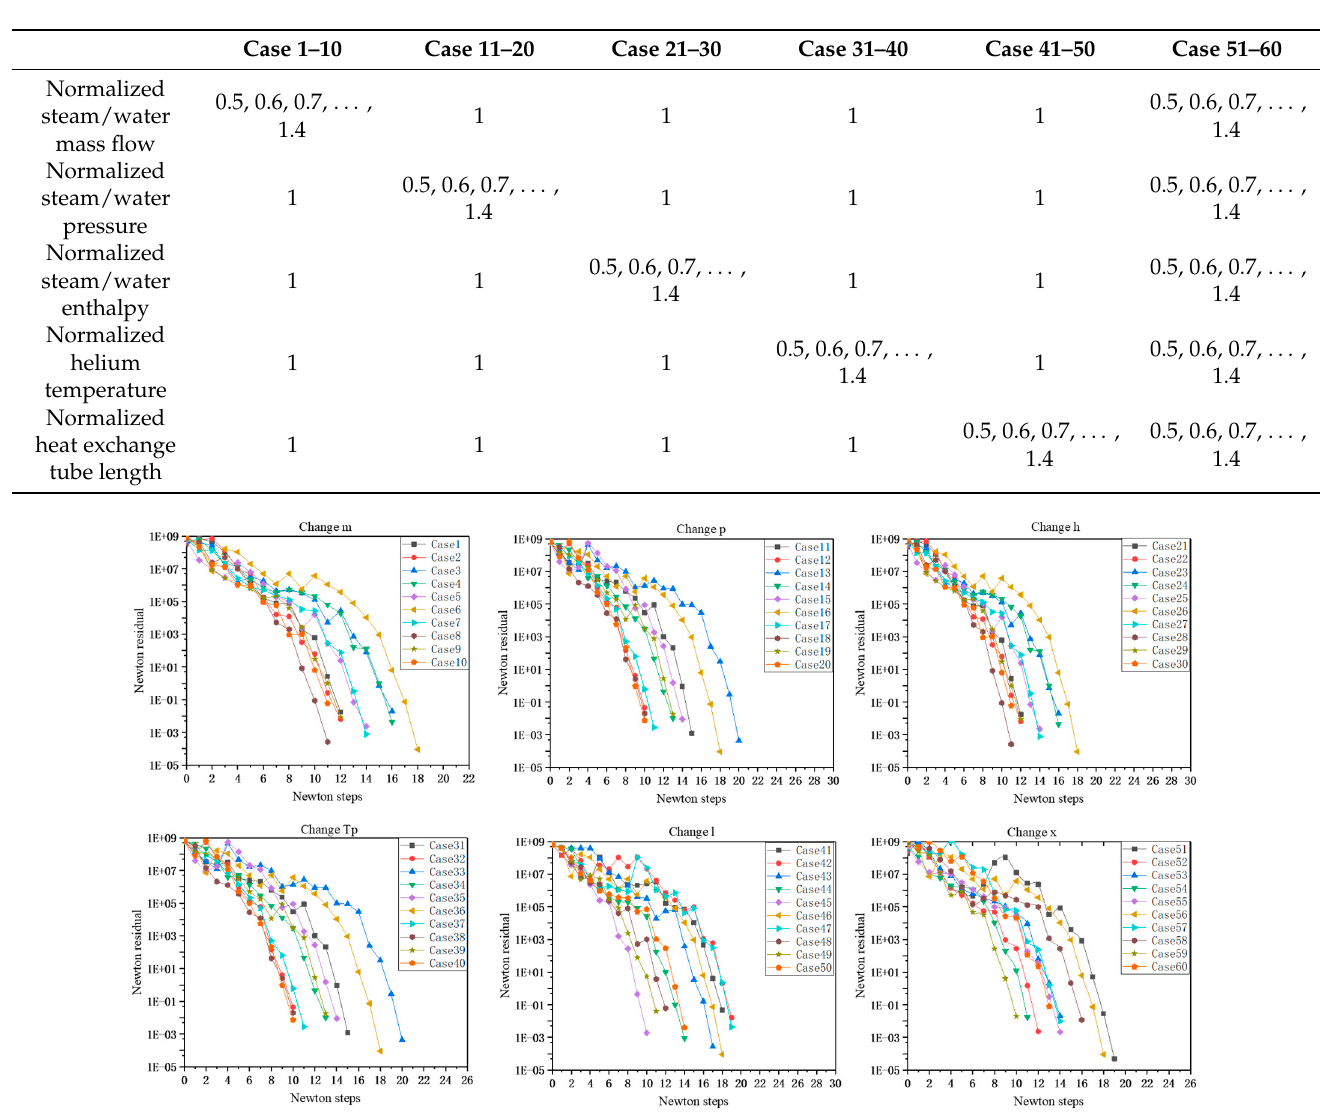
Table 3. Initial value choice.